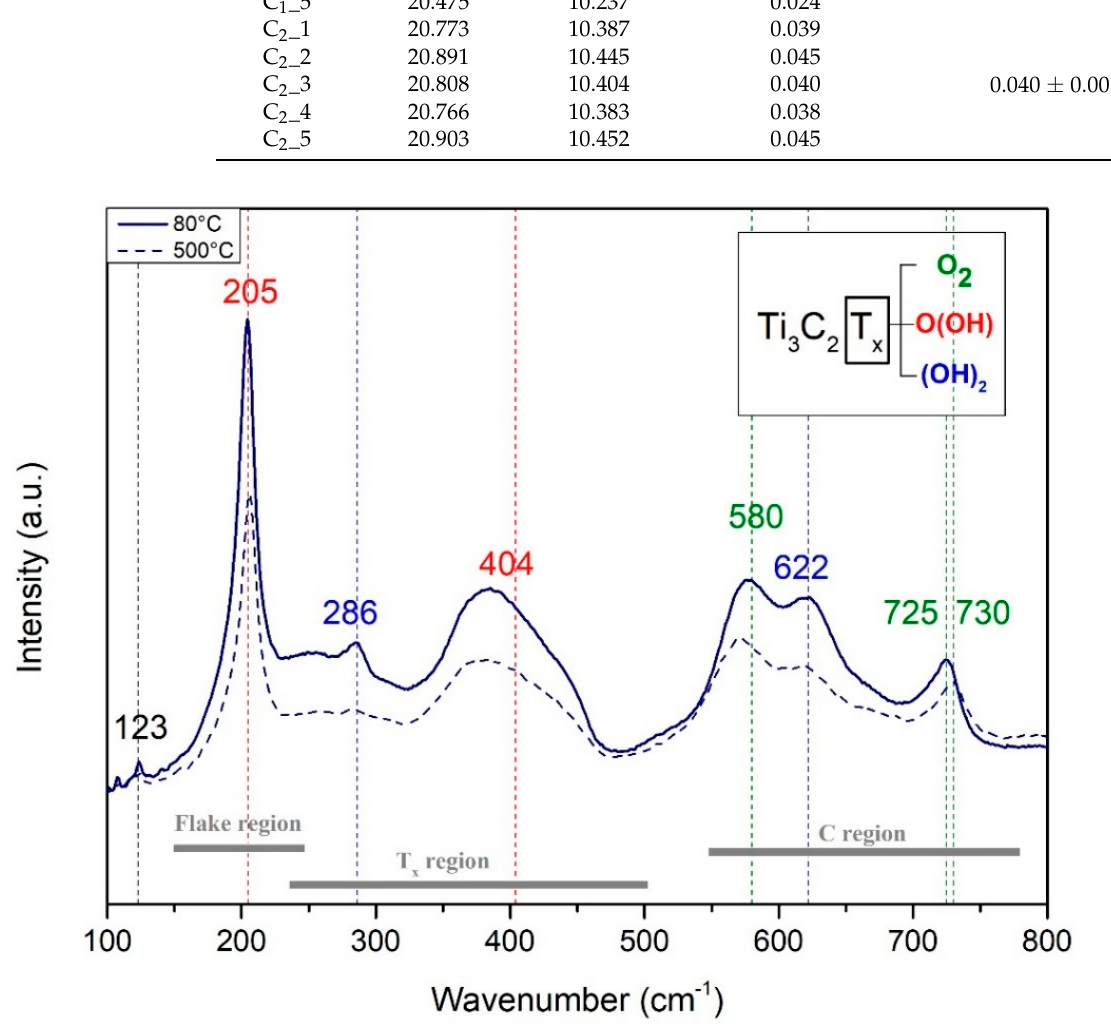
Figure 8. Raman spectra of Ti 3 C 2 (laser 532 nm). T x functional terminations were compared to the literature.